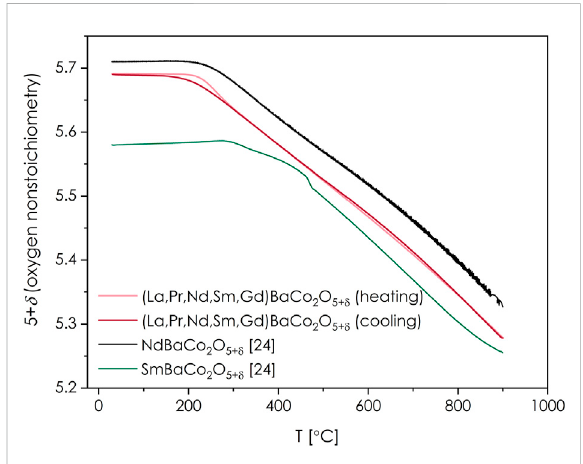
FIGURE 5 Temperature dependence of close to equilibrium oxygen content in (La,Pr,Nd,Sm,Gd)BaCo 2 O 5+ δ as determined by iodometric titration (initial data at RT) and TG measurements during both heating and cooling runs. Reference data for NdBaCo 2 O 5+ δ and SmBaCo 2 O 5+ δ are also included (Olszewska et al.,